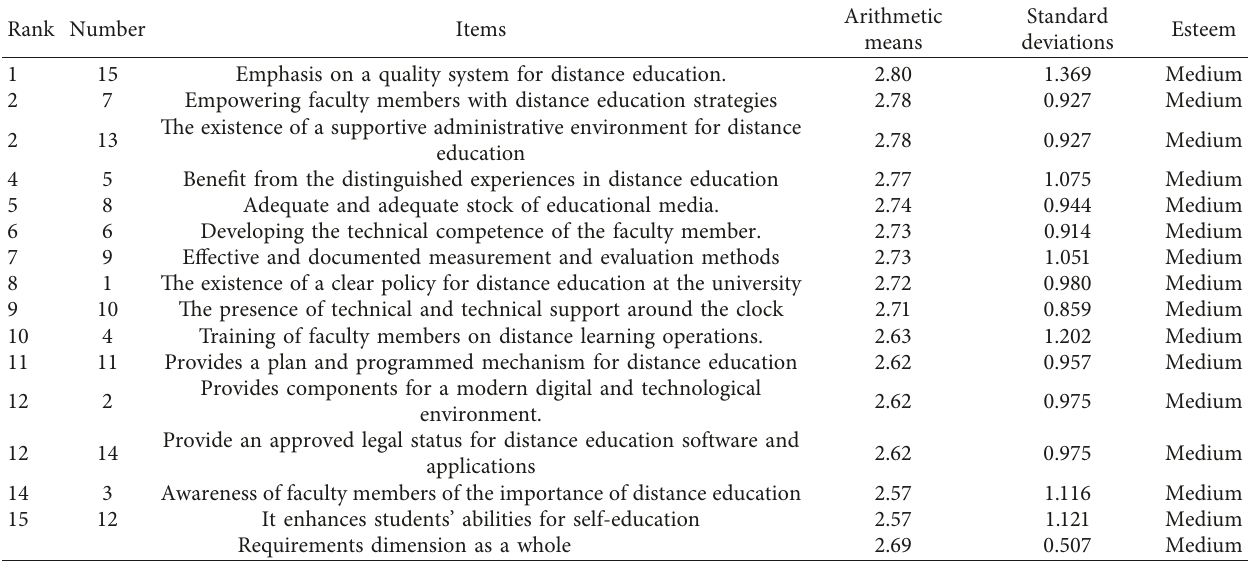
Table 5: Arithmetic means and standard deviations of the requirements dimension items are arranged in descending order. Rank